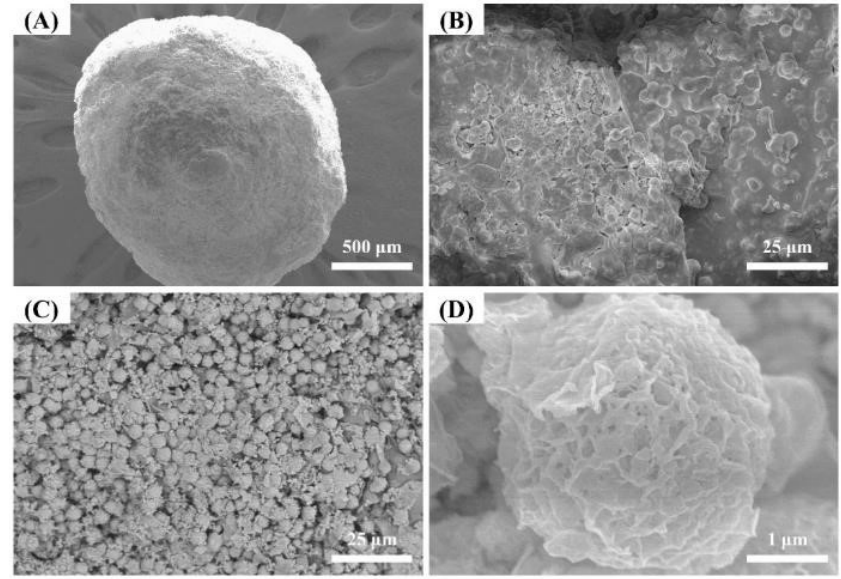
Figure 4. SEM images of the ( A , B ) surface and ( C , D ) cross-section of prepared Alg–BO. According to the N 2 adsorption–desorption hysteresis loop of Alg–BO (Figure 5), it can be classified as an H3 hysteresis loop based on the IUPAC classification [43]. This H3 hysteresis loop is known to be attributed to aggregates or agglomerates of particles with